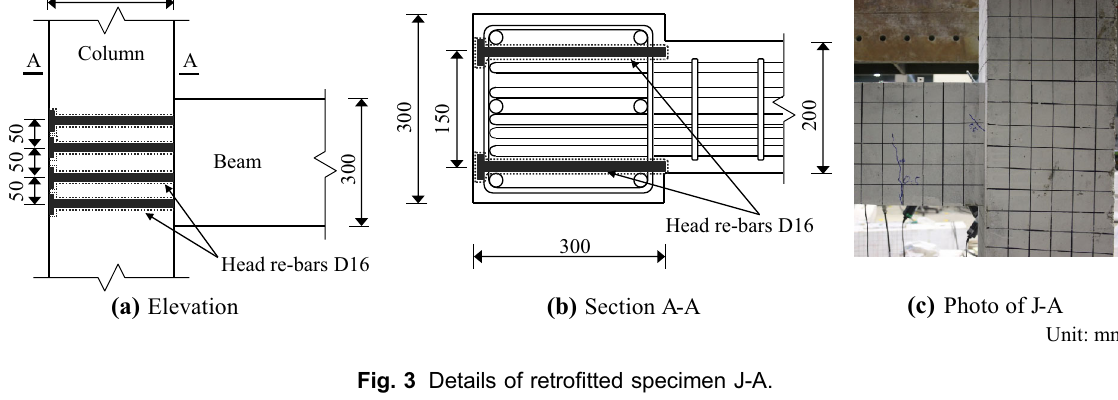
Fig. 3 Details of retrofitted specimen J-A.